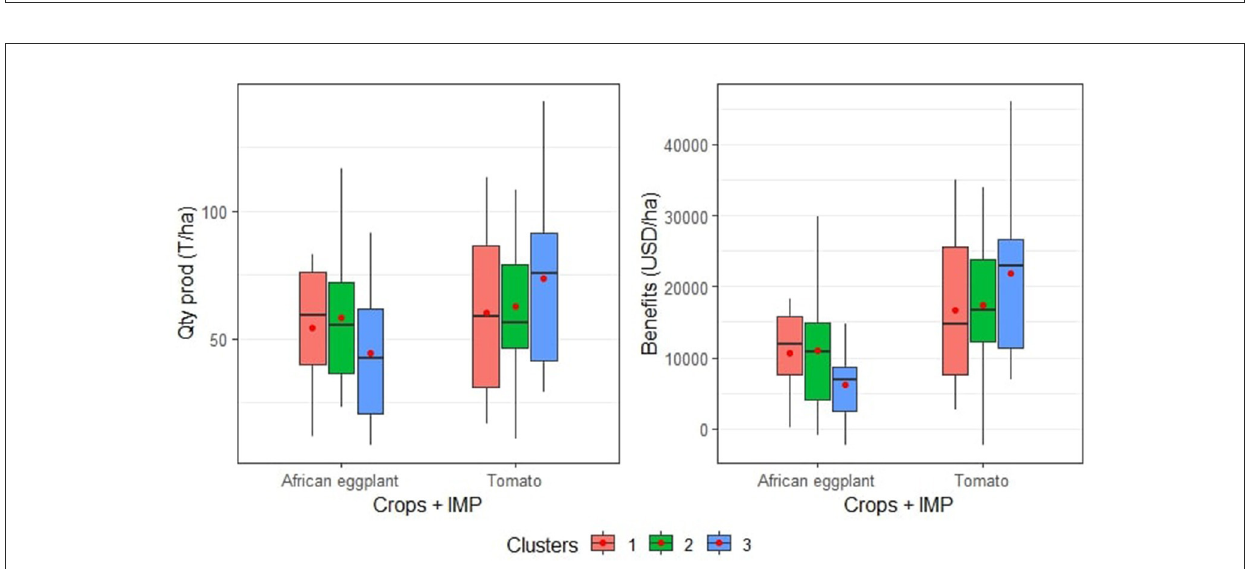
FIGURE5 The yield (Qty prod) and net benefit variability for African eggplant ( Tengeru White ) and the tomato ( Tengeru 2010 ) among the three environmental clusters. The red dots represent the mean of yield and benefits. Clusters 1 and 3 showed the highest yield and net benefit for African eggplant and Tengeru 2010 tomato, respectively, and were used as the reference for spatial